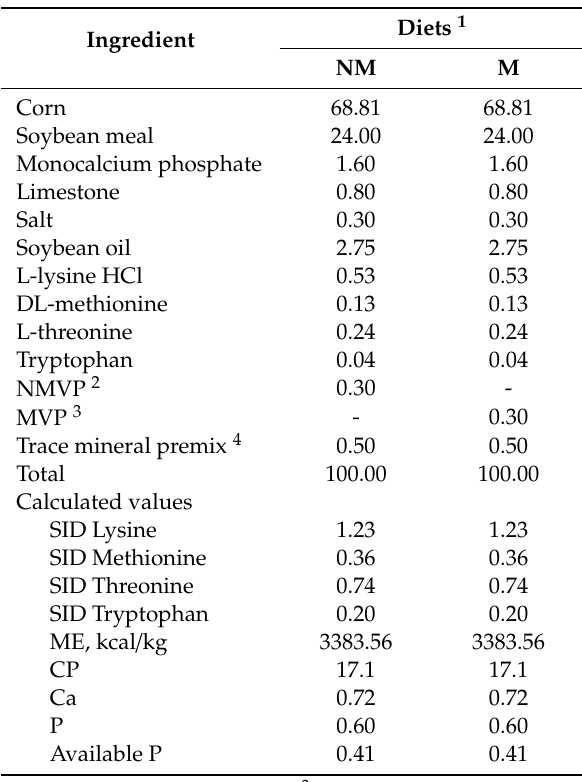
Table 1. Ingredient composition and calculated nutrients of the experimental diet (%, as-fed basis).